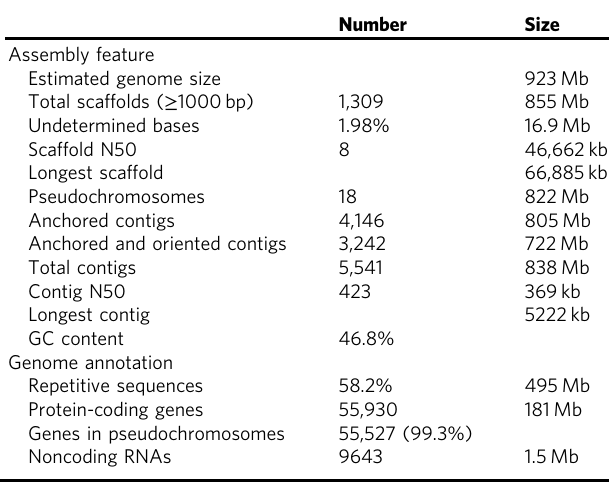
Table 1 Global statistics of P. miliaceum genome